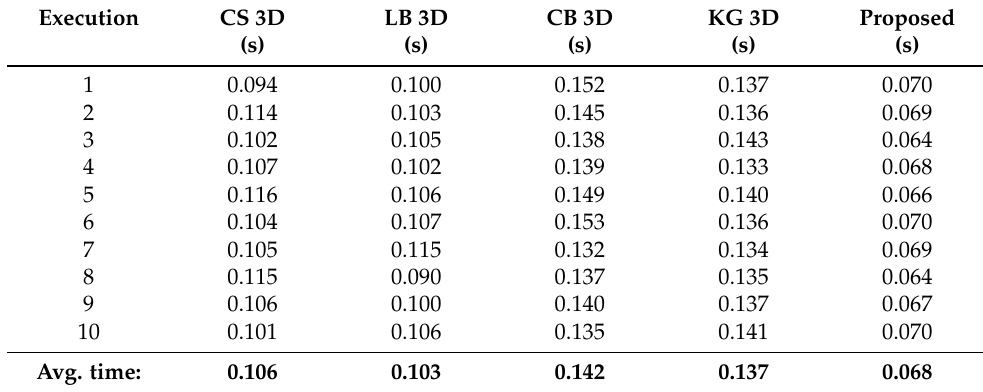
Table 1. Execution times of each algorithm when clipping one million